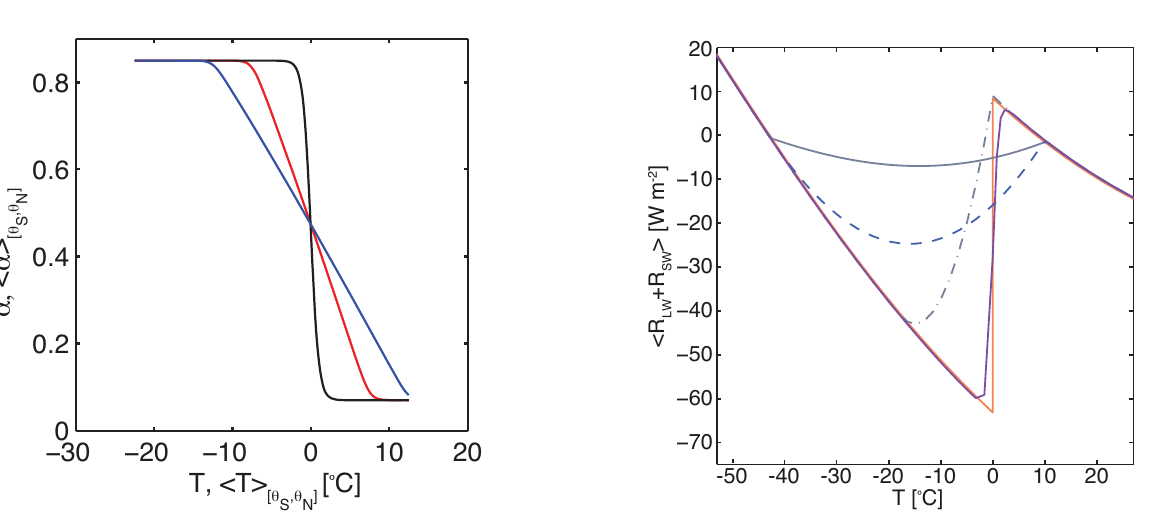
Fig. 8. Annual average surface energy budget h R LW + R SW i for the Fig. 7. Spatially averaged surface albedo h α(T ) i [ θ S ,θ N ] albedo parameterizations introduced in Fig. 3 and 1b = 0: ALW = (Eq. 9) versus spatially averaged surface temperature h T i [ θ S ,θ N ] (grey), AQW (dashed blue), AQN (grey dash-dotted), AST (purple), h T i [ θ + T = 60 ◦ N, θ N = 90 ◦ N, T = 1 ◦ C, 1 2 (Eq. 8) for θ S 0 S ,θ N ] ASE and different temperature gradients, T S = 0 ◦ C, T N = − 15 ◦ C (red graph) and T S = 5 ◦ C, T N = − 20 ◦ C (blue graph). The local step- like albedo α(T ) (Eq. 11) is plotted for reference (black graph).